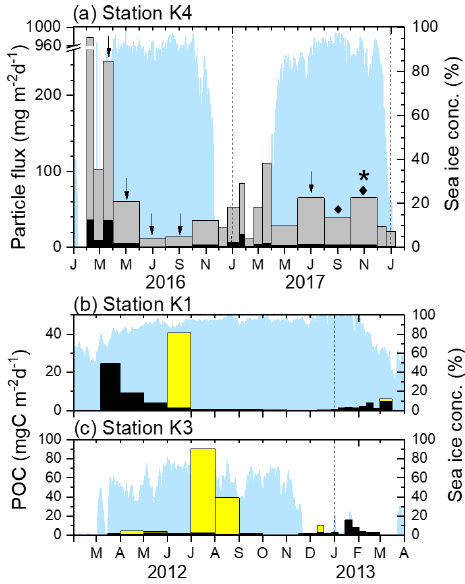
Figure 2. (a) Fluxes of sinking particles (gray bars) and POC (black bars) at Station K4. The tick marks on the x axis indicate the start of each month. The arrows, diamonds, and the star indicate the pe- riods when worms, scallops, and the sea urchin were collected, re- spectively. (b) POC fluxes due to worms (yellow bars) and sinking particles (black bars) at Stations K1 and (c) K3. Note that the y axis scales differ. The dotted vertical lines denote the beginning of each year. The blue shading indicates the sea ice concentration. POC flux and sea ice data for Stations K1 and K3 were redrawn from Kim et al.